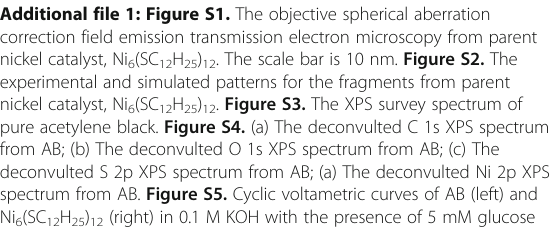
Additional file 1: Figure S1. The objective spherical aberration correction field emission transmission electron microscopy from